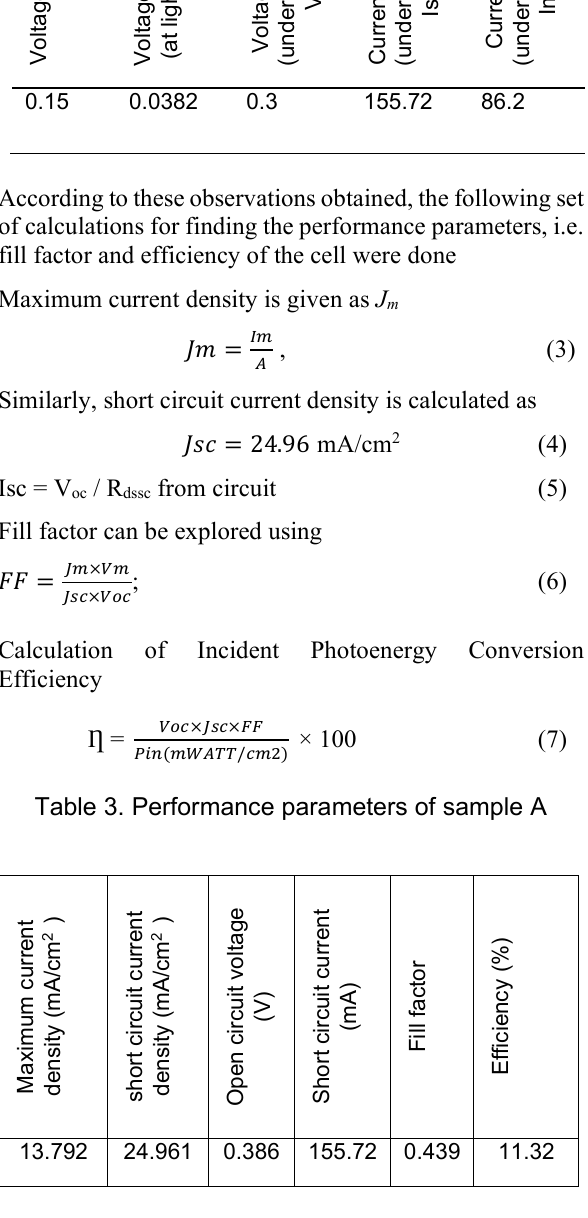
Table 2. Observations made for electrolyte sample A for load and no-load conditions.